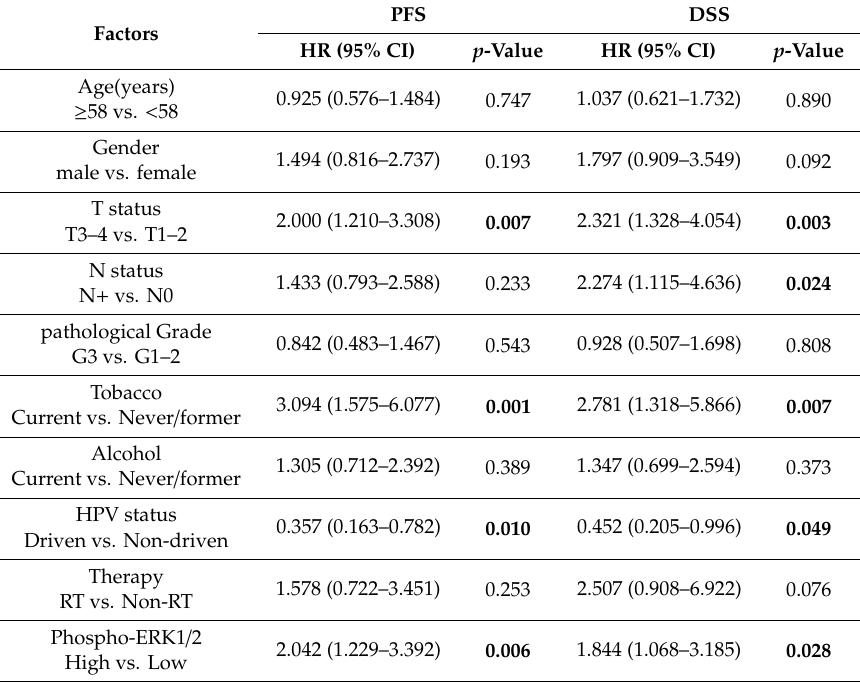
Table 2. Univariate Cox regression analysis of progression-free survival (PFS) and disease-specific survival (DSS) for oropharyngeal squamous cell carcinoma (OPSCC) patients ( n = 124).